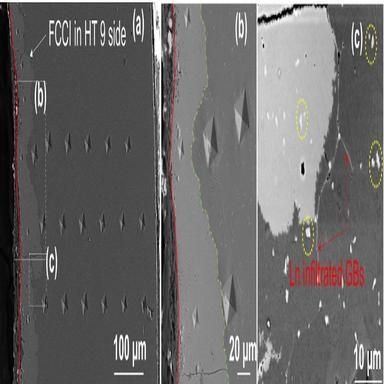
SEM images of HT9 cladding surface morphology/microstructure. (a) A low magnification SEM image showing the overall microstructure of a selected area. The red line highlighted the fuel cladding interface. Inside the HT9, fuel cladding chemical interaction (FCCI) region with a brighter contract formed. The boundary between FCCI and unreacted HT9 is highlighted by a green dash line in (b); (c) A high magnification SEM image illustrates Lanthanides (Lns) infiltrated grain boundaries (GBs) and Mo segregation (y